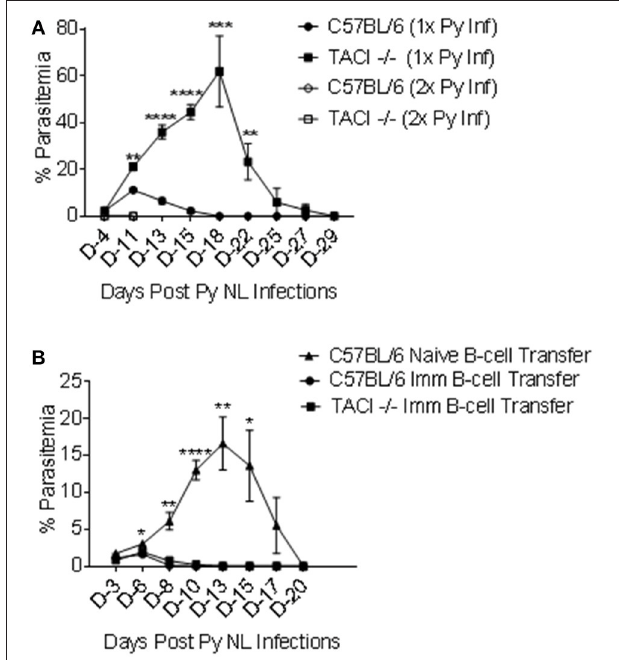
FIGURE 6 | TACI -/- mice are resistant to re-infection with P. yoelii and P. yoelii experienced TACI -/- mice B cells are protective. (A) TACI -/- and C57BL/6 mice were re-infected (i.p.) with 1 × 10 6 P. yoelii (Py 17XNL) parasites 11 months after the first infection (2x Py inf). A second group of naïve TACI -/- and C57BL/6 mice was infected for the first time to recapture the first infection parasitemia (1x Py inf). Parasitemia levels were evaluated by blood smears at indicated days post challenges. Results are expressed as mean % parasitemia ± SEM for 10 mice per group for first challenge, and for 5 mice per group for the second challenge. Unpaired student’s t- test was used for statistical evaluation. *indicates p < 0.05, ** p < 0.01;*** p < 0.001; and **** p < 0.0001 when comparing 1x Py NL and 2x Py infected TACI -/- mice. Experiment was performed once. (B) B cells from naive C57BL/6 or P. yoelii 17XNL infected C57BL/6 and TACI -/- mice were adoptively transferred into 3 to 4 naïve C57BL/6 mice. Two hours after B-cell transfer, mice were challenged (i.p.) with 1 × 10 6 P. yoelii parasites and parasitemia were assessed on indicated days. Unpaired student’s t test was used for statistical evaluation. Results are expressed as mean % parasitemia ± SEM. *indicates p < 0.05, ** p < 0.01;*** p < 0.001; and **** p < 0.0001 when comparing the naïve B cell transfer and the TACI -/- B cell transfer groups. Experiment was performed